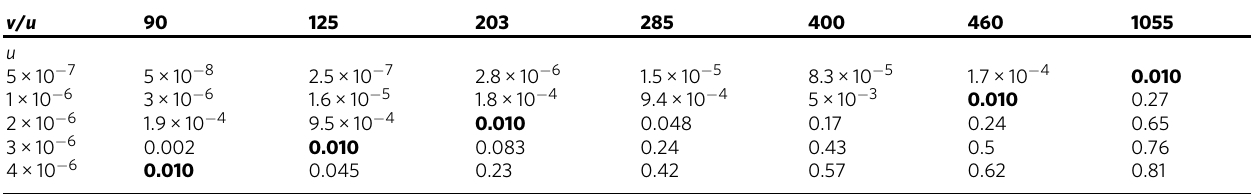
Table 3 Penetration of fi ve mutations Fo 5 + Fm 5 after 900 generations v /